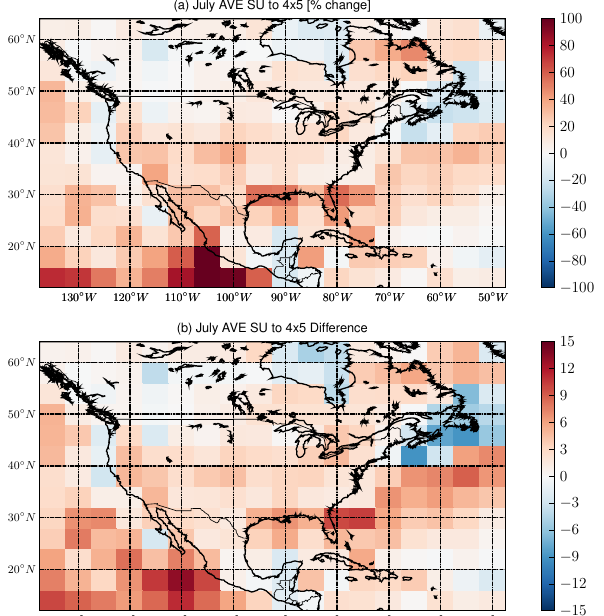
Fig. 10. SOM partitioning ratio (SOA/SOM) comparisons between the scaled up 0.5 ◦ × 0.667 ◦ simulations (SU) and the 4 ◦ × 5 ◦ simu- lations averaged over July. Panel (a) is the % difference between the SU and 4 ◦ × 5 ◦ partitioning ratios and (b) is the absolute difference (also units of percent since the partitioning ratio is also calculated as a percent).